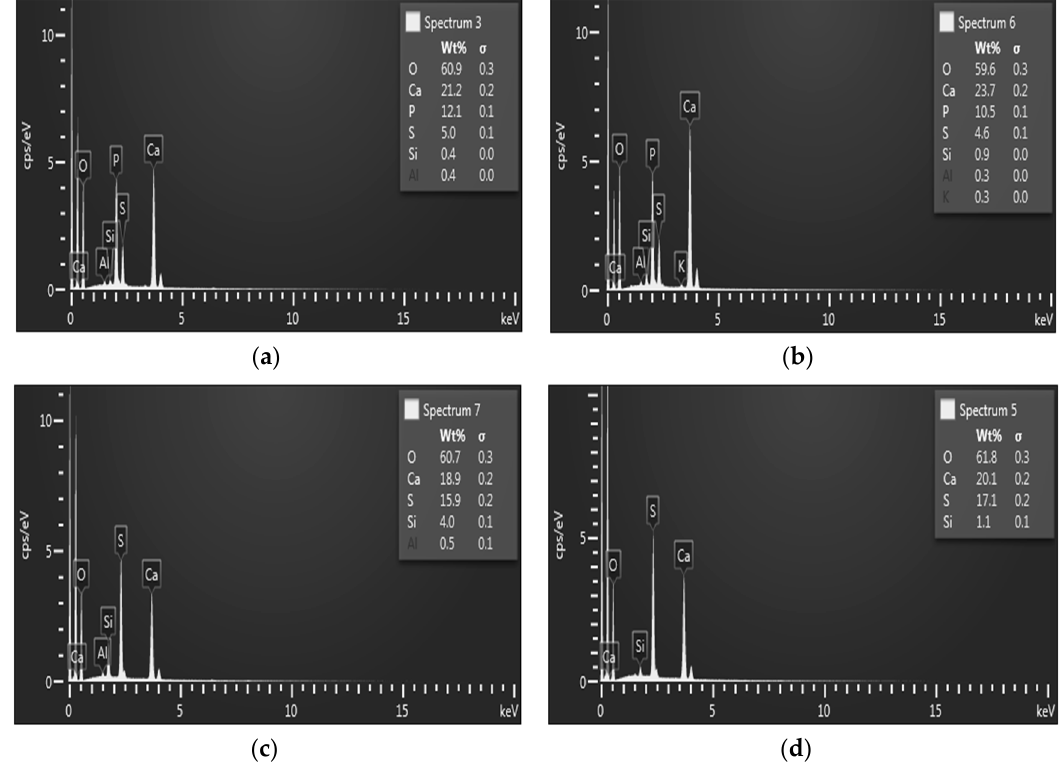
Figure 10. Energy dispersive X-ray microanalysis (EDX) semi-quantitative analysis of ( a ) M0-6; ( b ) M1-6; ( c ) M0-2; and ( d ) M1-2 samples.